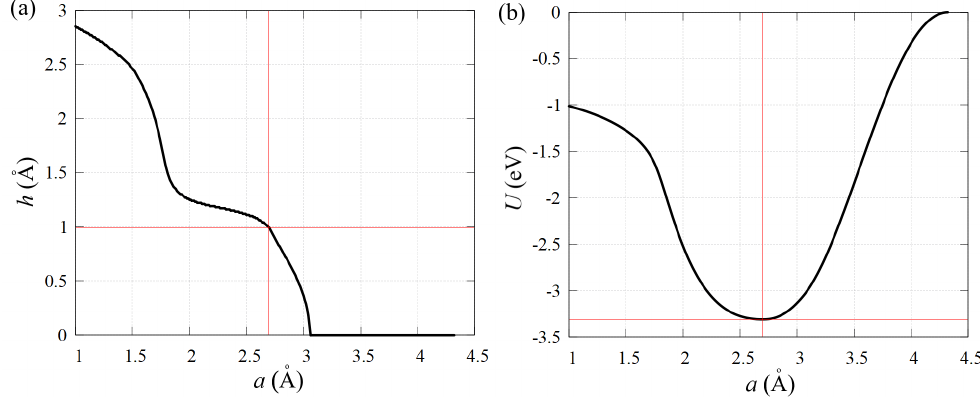
Figure 2. Dependence of ( a ) stanene height h and ( b ) potential energy per atom U on the lattice parameter a during relaxation with preservation of the hexagonal structure to find the equilibrium state. The red lines indicate the equilibrium state of the stanene